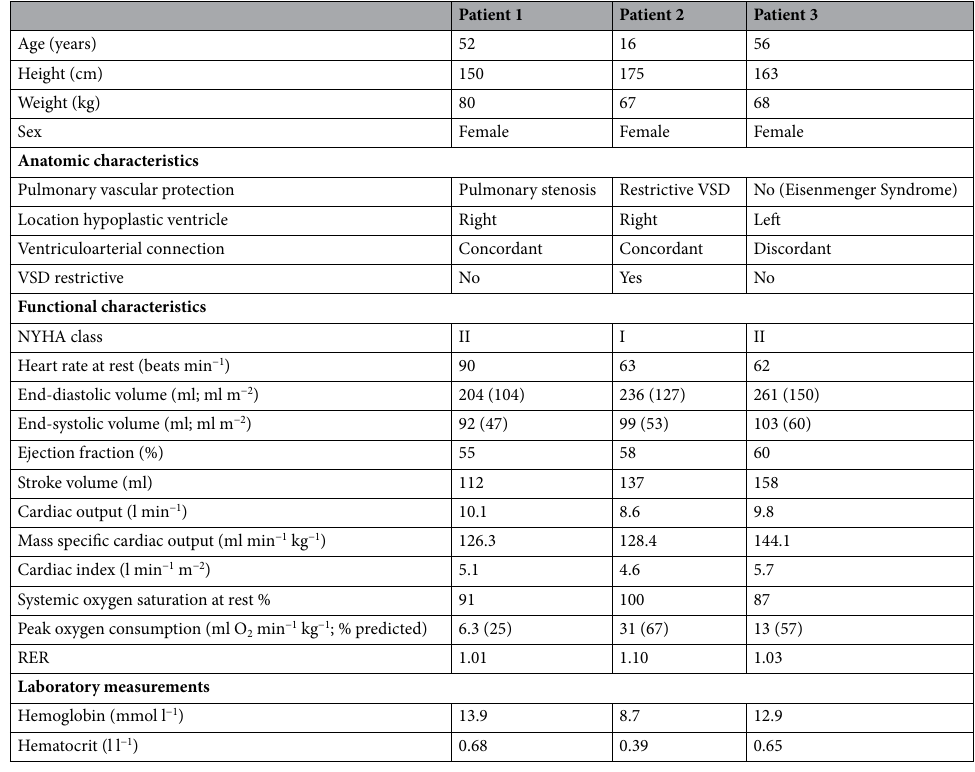
Table 2. Overview of the DILV